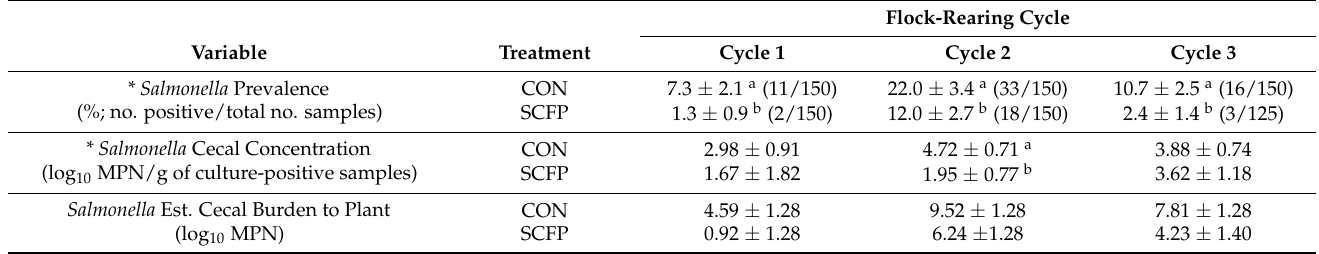
Table 3. LS means estimates for prevalence and load of Salmonella enterica in the ceca of broilers at market age fed either CON or SCFP diets by flock-rearing cycle and estimated treatment level within-cycle total